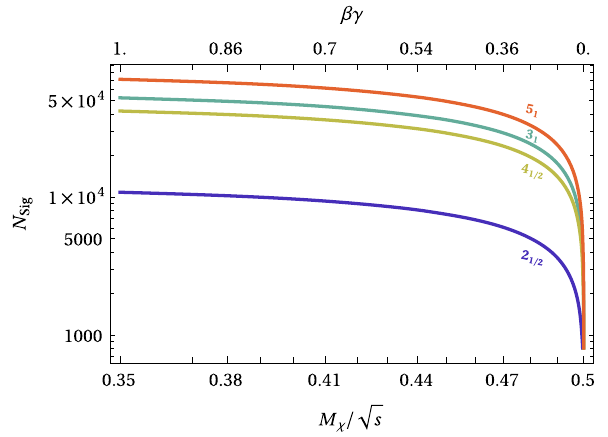
Fig. 5 Signal yield of the charged tracks for the 2 1 / 2 , 3 1 , 4 1 / 2 , 5 1 . The √ s in the tens of TeV range, assuming the luminosity plot holds for all scales as Eq. (20). The cuts applied on the produced charged χ ’s are p T > 200 GeV, | η χ | <